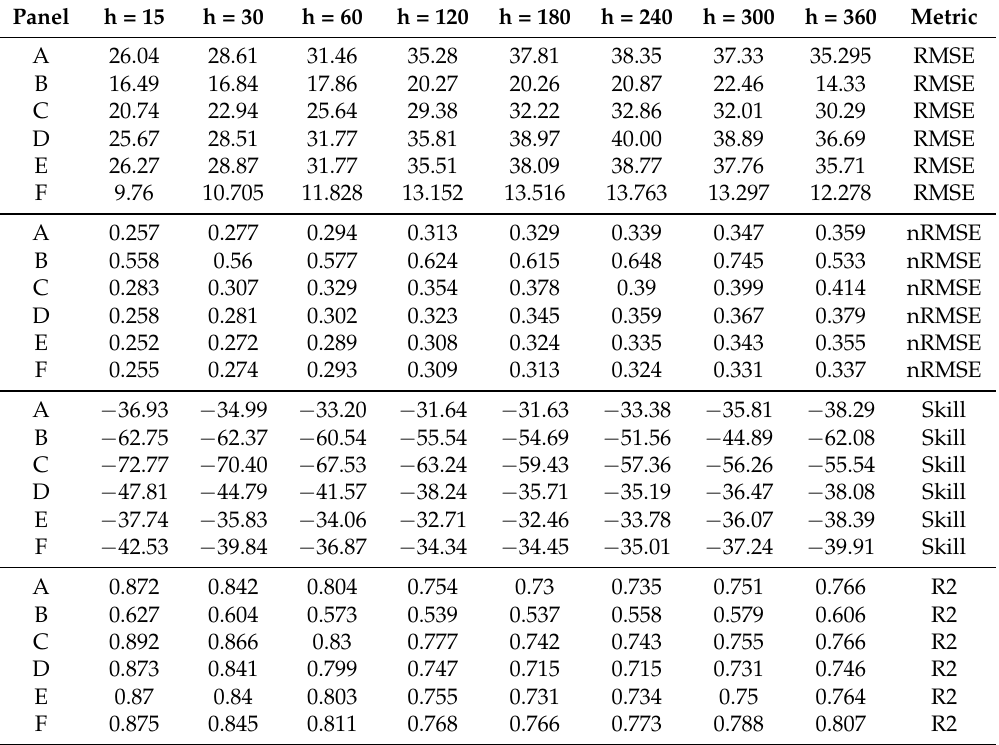
Table 3. Panel metric numerical